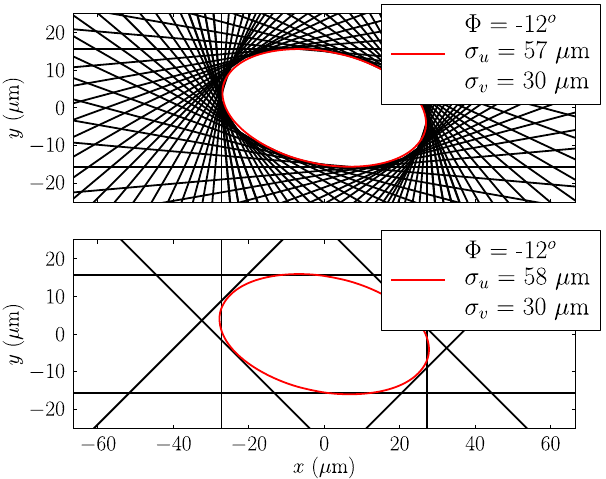
FIG. 7. In the first plot the full reconstruction of the transverse beam shape using tangents lines, in the second only the lines obtained by the projections at 0°, 45°, 90°, and 135° are considered. The red ellipses are drawn using the results of the fit presented in Fig. 9.